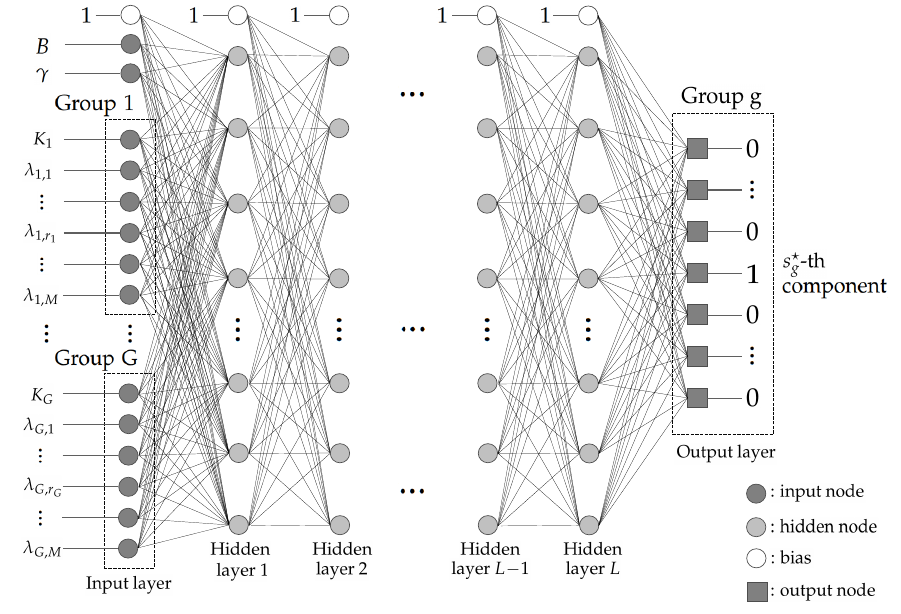
Figure 4. The proposed DNN